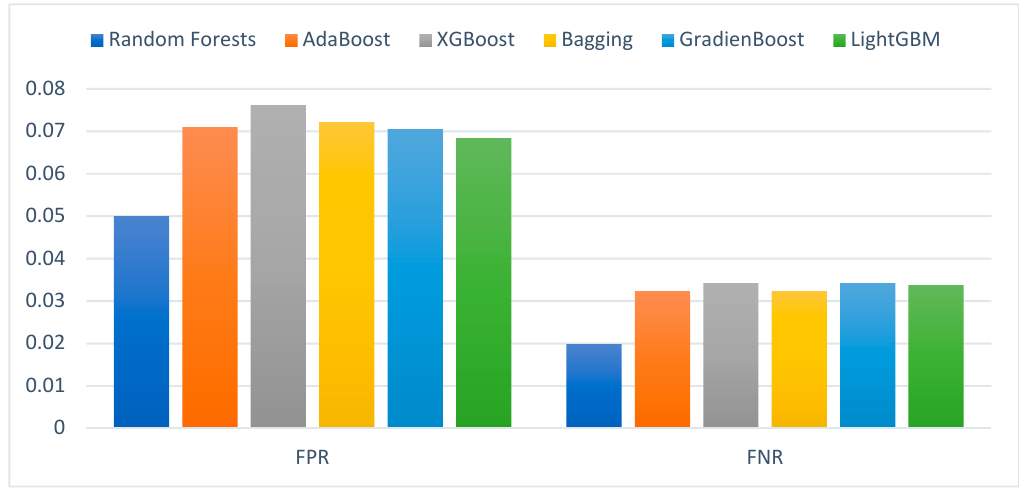
Figure 3. Comparisons of the FPR and FNR of ensemble methods for Dataset 2.